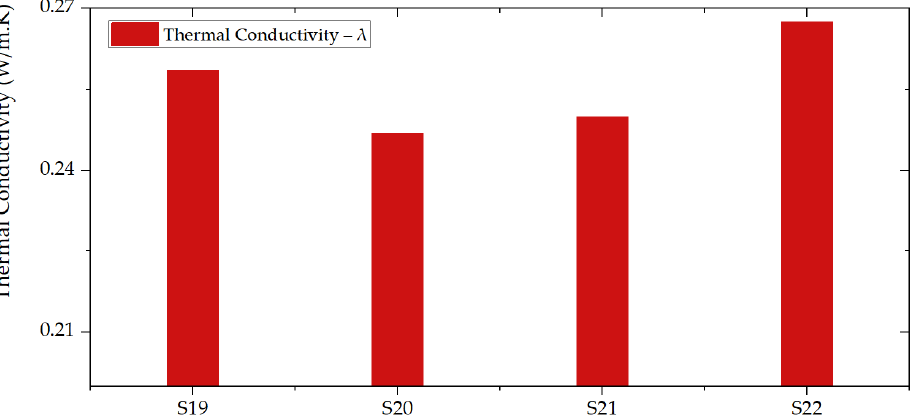
Figure 7. Thermal conductivity of GFs: S20 has the lowest thermal conductivity among the synthe- tized geopolymers.